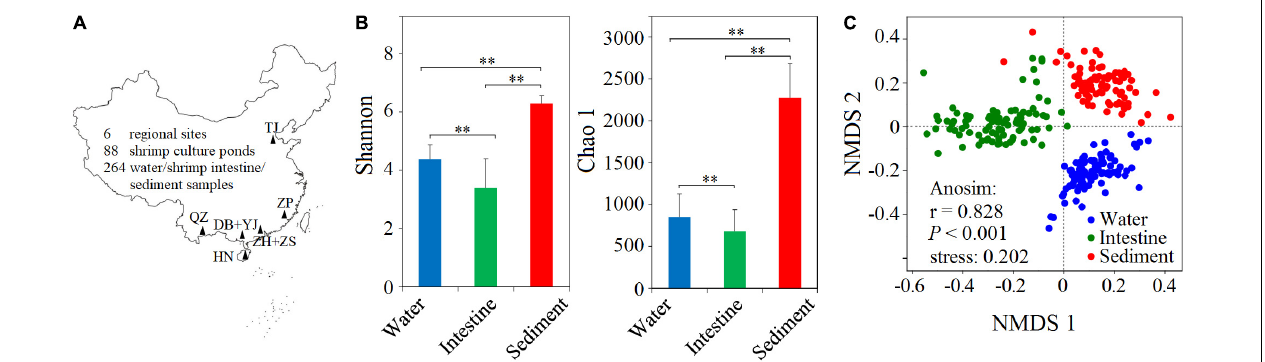
FIGURE 1 | Sampling sites and the α - and β -diversity of microbial communities from three habitats. (A) A total of 264 water, shrimp intestine, and sediment samples (88 samples in each habitat) were collected from 88 cultural ponds in six regions in China. DB + YJ, ZH + ZS, HN, QZ, ZP, and TJ indicate Dianbai + Yangjiang, Zhuhai + Zhongshan, Hainan, Qingzhou, Zhangpu, and Tianjin. (B) The α -diversity of microbial communities among water, shrimp intestine, and sediment habitats in the SCPE of six regions. Statistical significance of the α -diversity indices among three habitats were based on the Welch’s t -test ( ∗∗ : P < 0.01). (C) The β -diversity of microbial communities of three habitats analyzed by NMDS and ANOSIM based on the Bray–Curtis